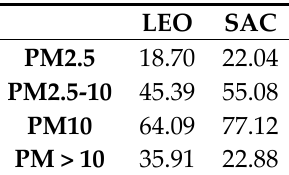
Table 1. Percentages of the total mean mass concentration for the fractions PM2.5, PM2.5-10, PM10 and PM >